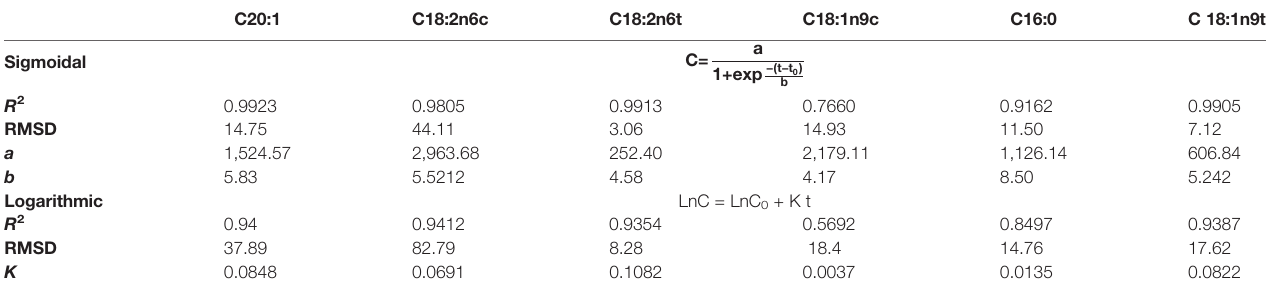
TABLE 1 | Sigmoidal and logarithmic kinetics models for the prediction of FAME produced by C . vulgaris